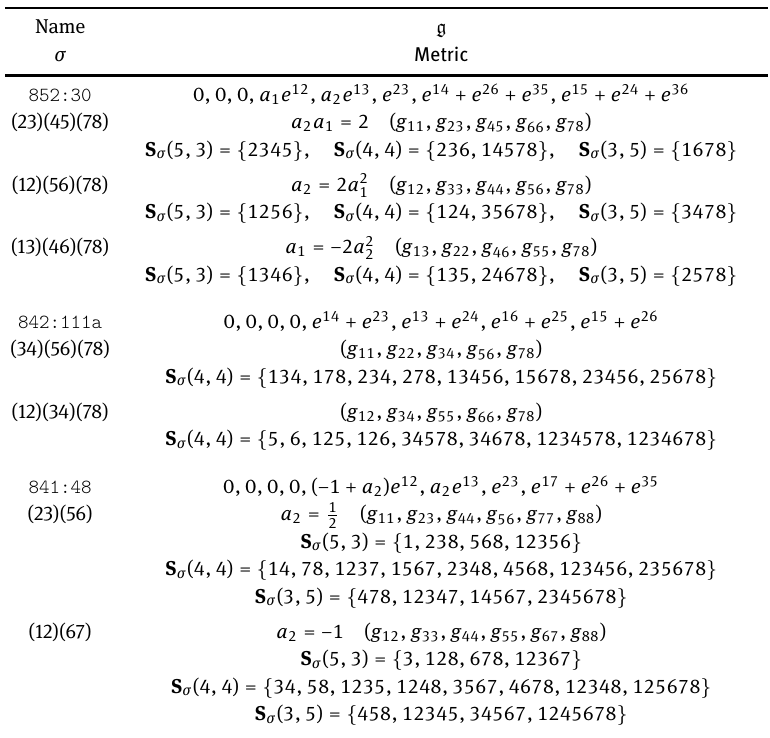
Table 4: 8-dimensional nice nilpotent Lie algebras that admit an order two automorphism σ and that satisfy ( K ), ( H ), ( L σ ) and ( P σ ) for k =